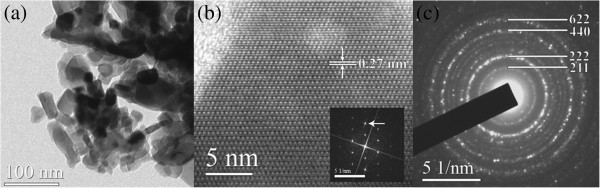
TEM data from Y1.97Yb0.02Er0.01O3 sample. (a) Bright-field image showing nanoparticle cluster. (b) [110] lattice image of a single particle. The 004 planes are indicated. Inset: FFT of image (indicated spot corresponds to 004 periodicity). (c) Selected-area diffraction pattern of nanoparticle cluster. Prominent planes are indexed.